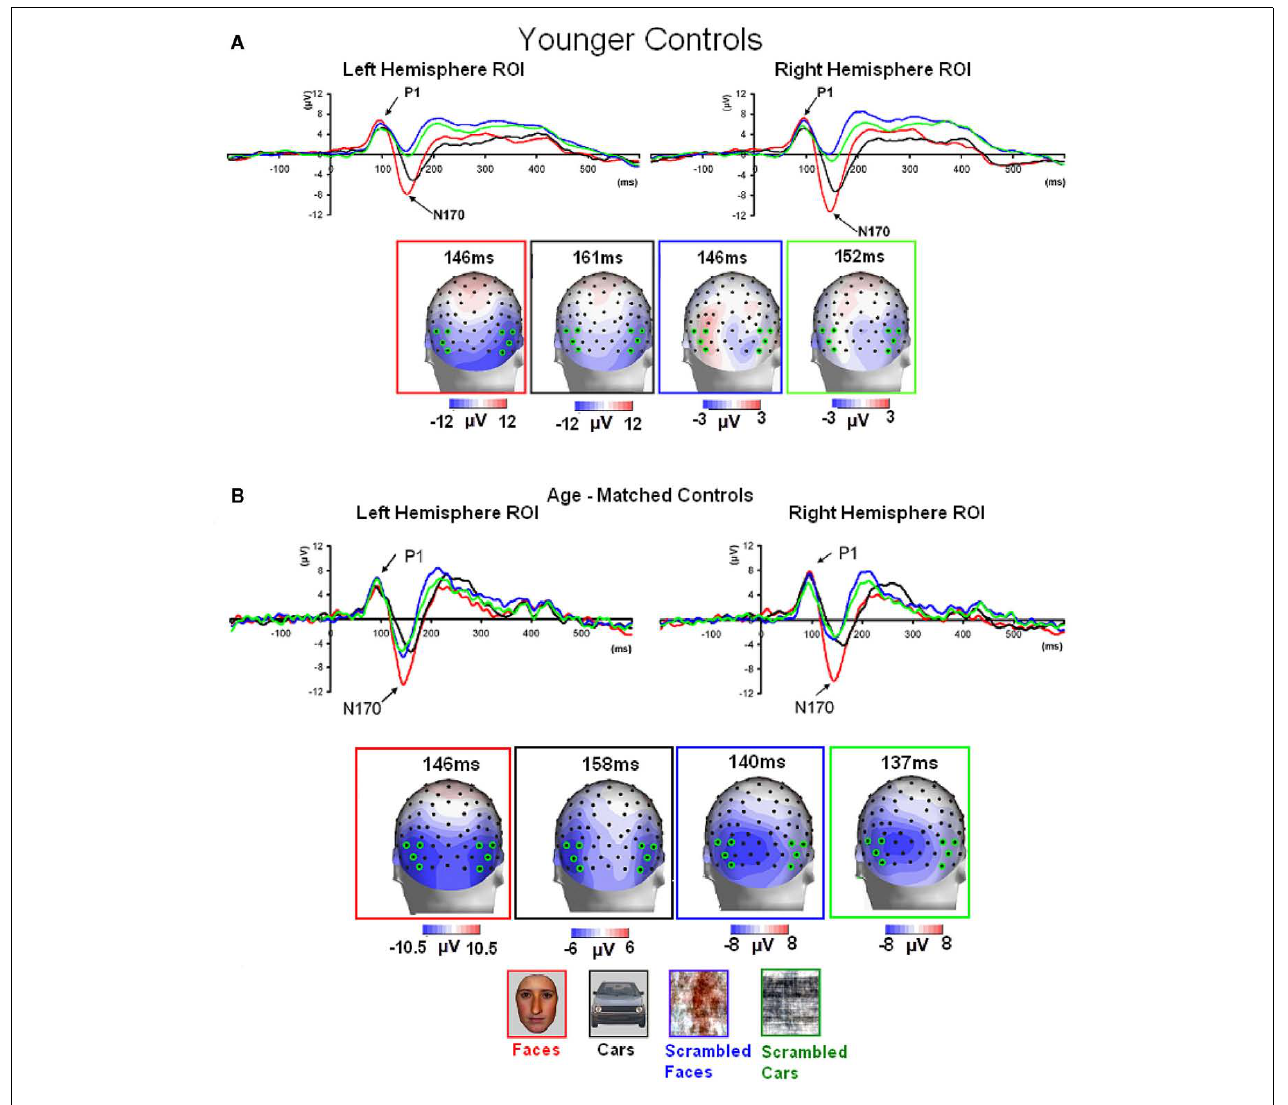
larger in amplitude both to faces and phase-scrambled faces than to cars and phase-scrambled cars. In contrast, the N170 was small for meaningless (phase-scrambled) stimuli, and showed a larger response to faces than cars.